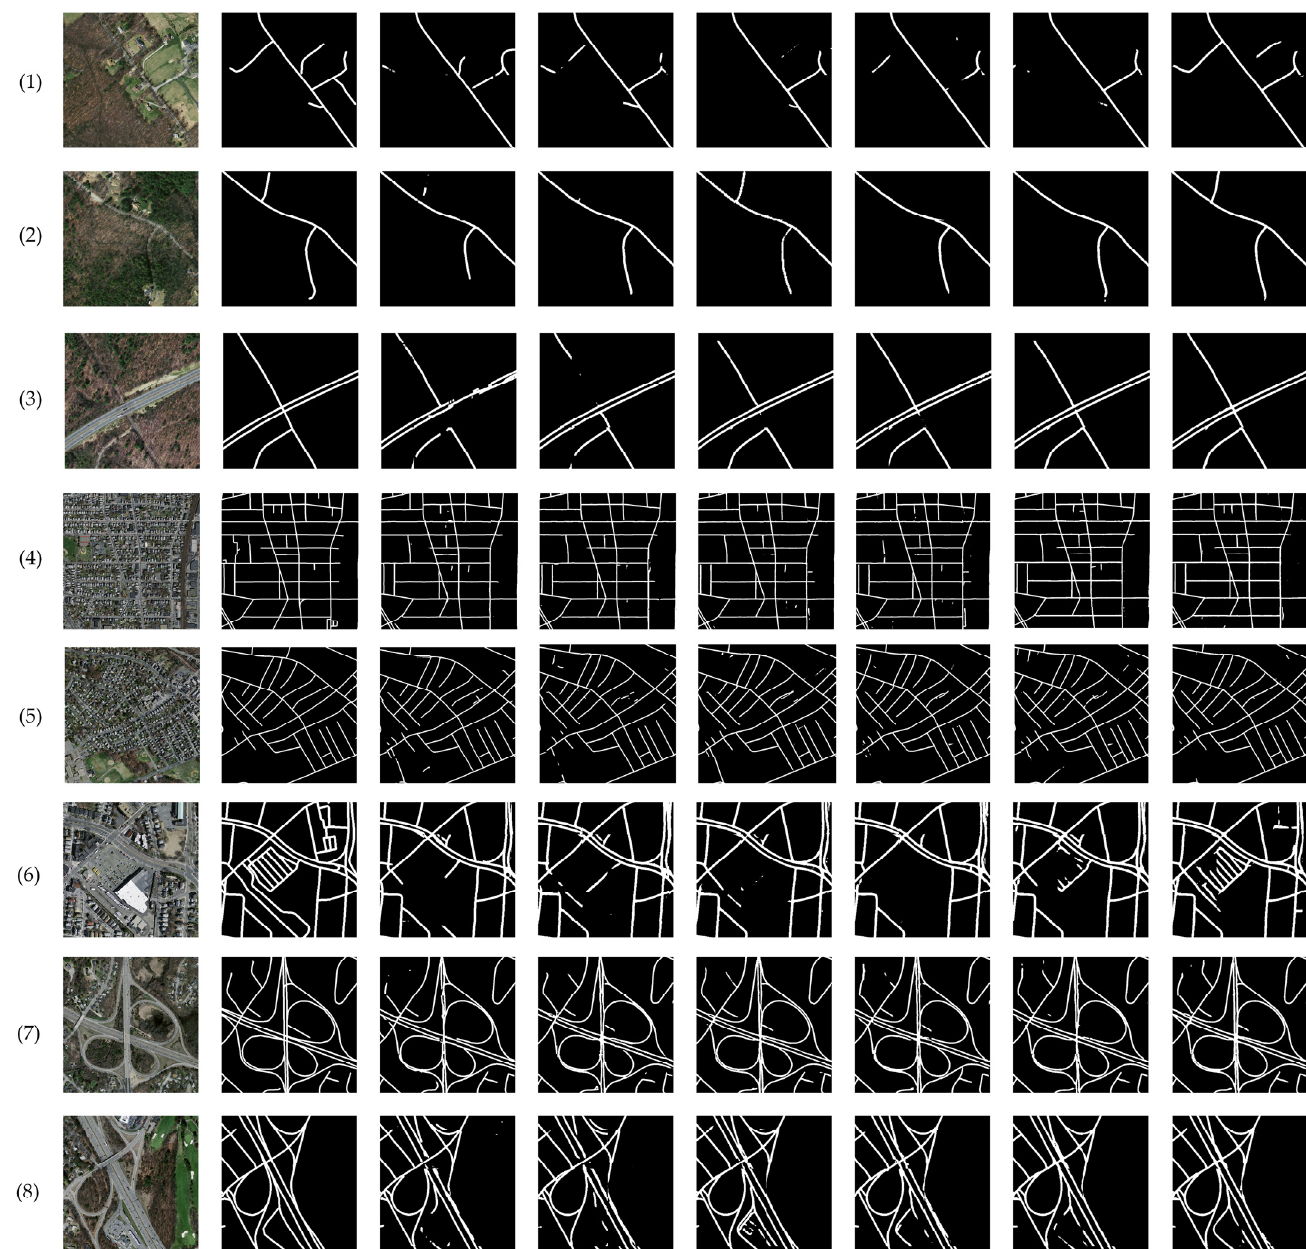
Figure 8. Connectivity of the road networks extracted from the Massachusetts roads dataset. ( 1 – 3 ) The rural roads; ( 4,5 ) The suburban roads; ( 6 ) The urban roads; ( 7,8 ) The transportation hub roads.